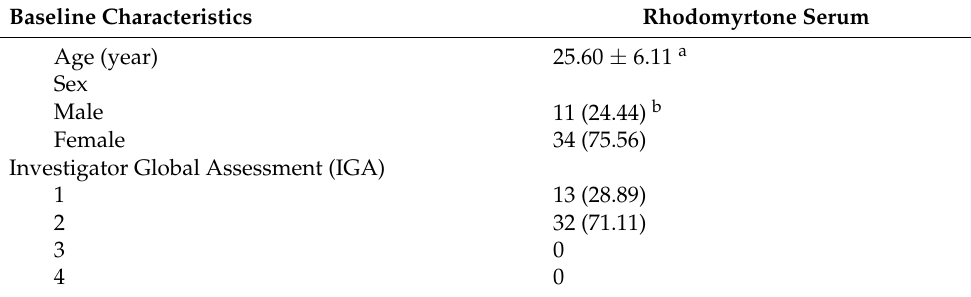
Table 5. Baseline characteristics in 45 volunteers.